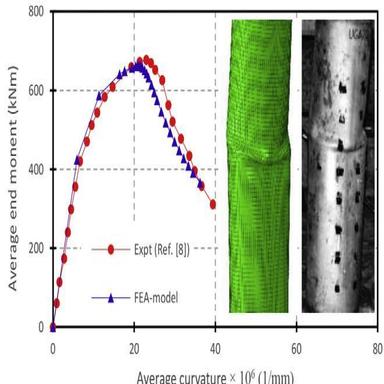
Comparison of FEA result with experimental result (UGA508) by Ref..